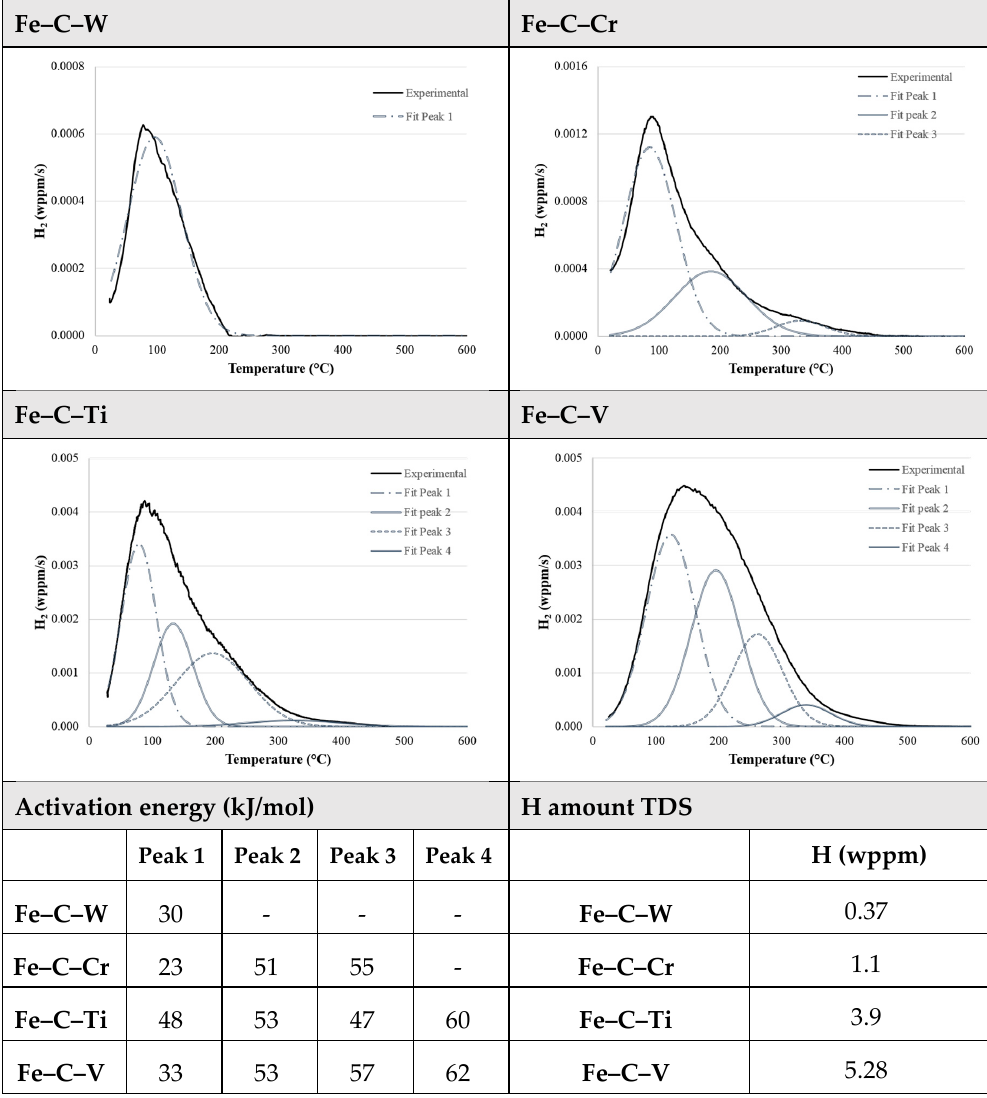
Figure 6. Thermal desorption spectroscopy (TDS) spectra, activation energies (kJ/mol) corresponding to the deconvoluted peaks and the amount of hydrogen (wppm) determined from the TDS spectra. Alongside the small carbides, precipitates larger than 100 nm were also observed in the Fe–C– Cr alloy. However, these were demonstrated not to be able to trap hydrogen [28]. Nevertheless, they can be seen as diffusion obstacles surrounded by a very high potential barrier. When these obstacles would occupy a volume inaccessible to hydrogen, they are able to lower the hydrogen solubility and diffusivity of the material. Leblond and Dubois [47] proposed an equation where the lowering of diffusion due to the presence of obstacles is incorporated. They stated that the influence of these obstacles should be negligible, except in some special cases where there is a localized high obstacle concentration. However, in the present material, the concentration of these large particles is rather